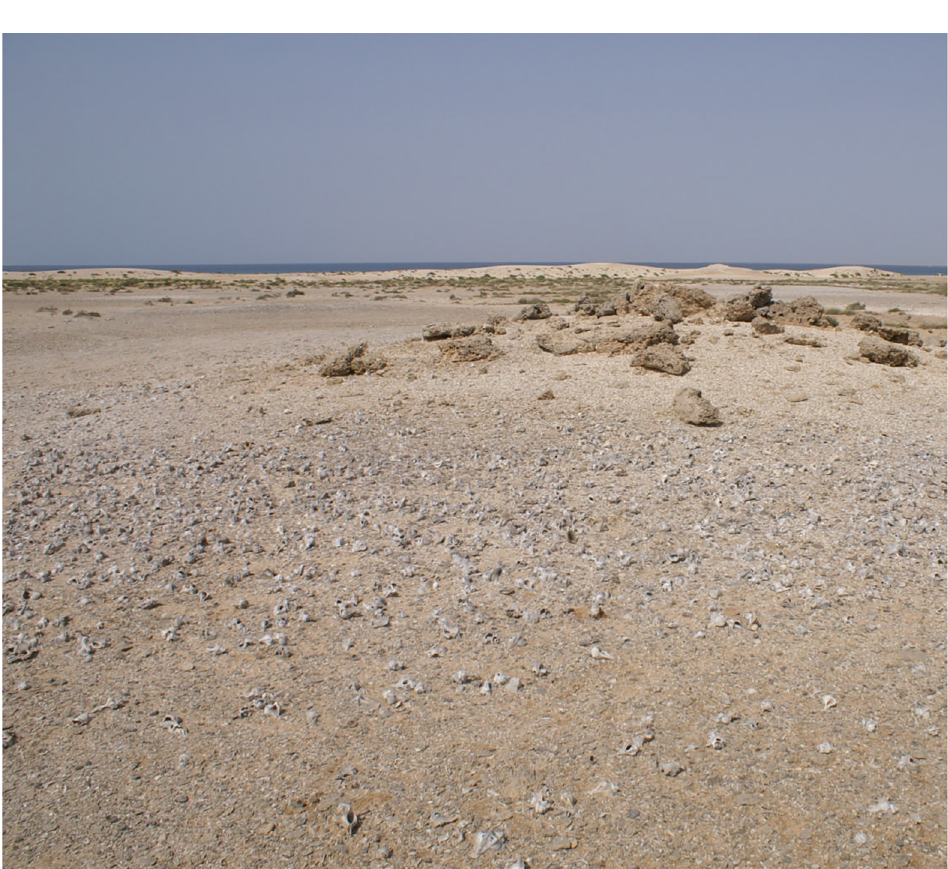
Fig 5. Post-shore shell scatter in the Janaba East cluster associated with Transect 3. The site appears to be a low mound with a deflated shell scatter on the surface and coral blocks representing the remains of structures but has not been excavated or dated. Photograph taken facing West, shell mounds along palaeoshorelines are clearly visible in the distance. To the right is the shell scatter of JE5641, identifiable by the patch of red material, which is the spoil heap from the trench excavated into this deposit. Photo by Geoff Bailey, February